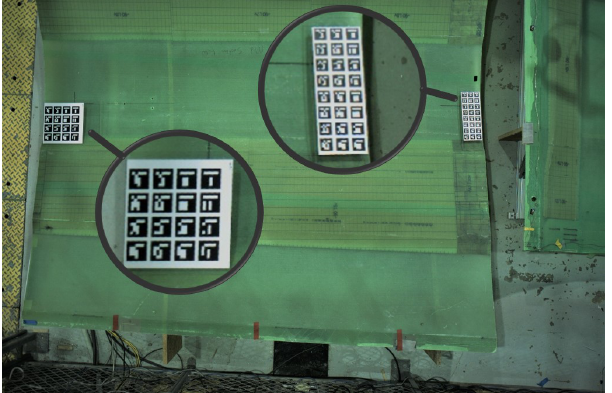
Figure 6. View from the overhead camera using multiple ArUco markers for the panel pose estimation. The estimated panel pose is then used to determine the grasp location of the vacuum